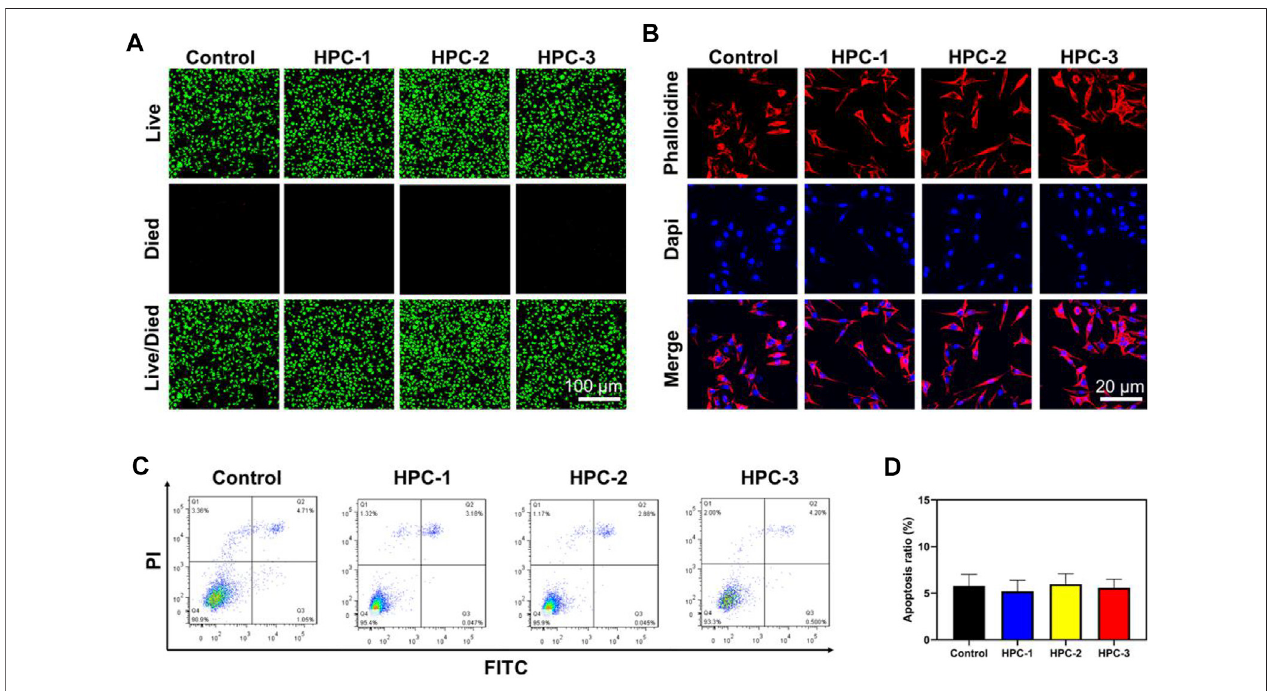
FIGURE5| TheHPChydrogelssupportedtheadhesionofL929cells. (A) Calcein-AM/PIdoublestainingofL929cellstreatedwithHPC-1,-2and-3hydrogels. (B) IF images of F-actin. Blue signal: DAPI; red signal: F-actin. (C) Flow cytometry (FCM) analysis and (D) the corresponding apoptotic rate statistical result of the HPC